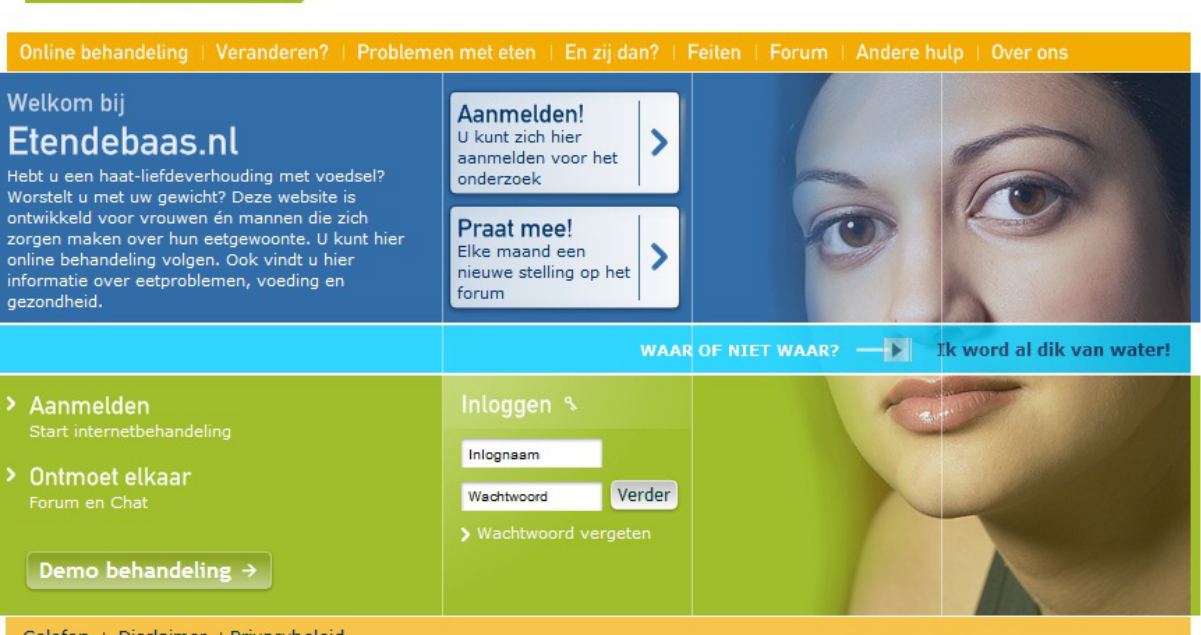
Figure 1. Homepage of the